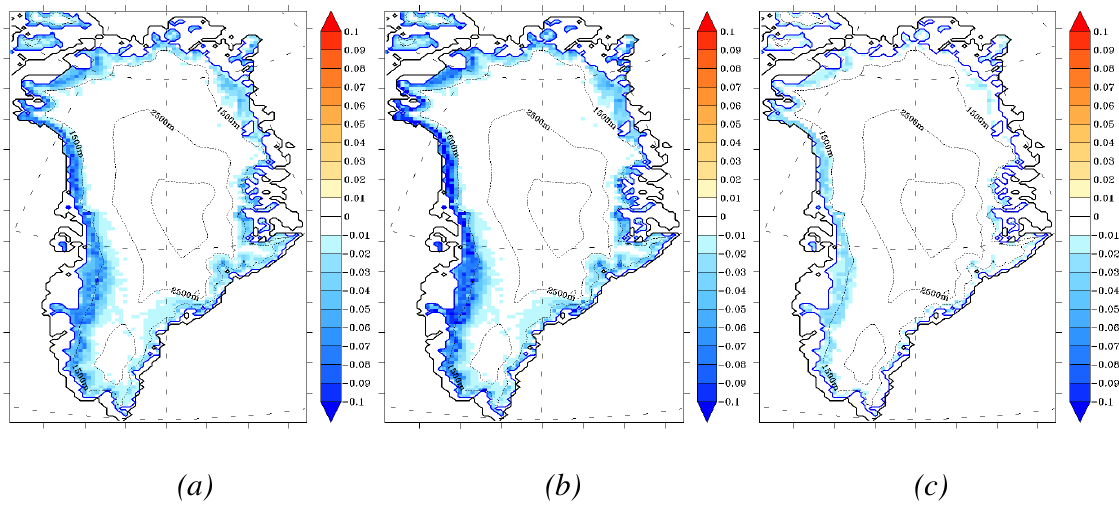
Figure 6 Figure 6. Maps of MAR-simulated albedo trends between 1996 and 2012 using (a) the original MAR albedo scheme and (b) the perturbated MAR outputs in which daily albedo is artificially decreased by 0.1 from the MAR-computed value for those regions where bare ice is exposed. (c) Difference between the trends obtained with MAR original albedo scheme and the perturbated